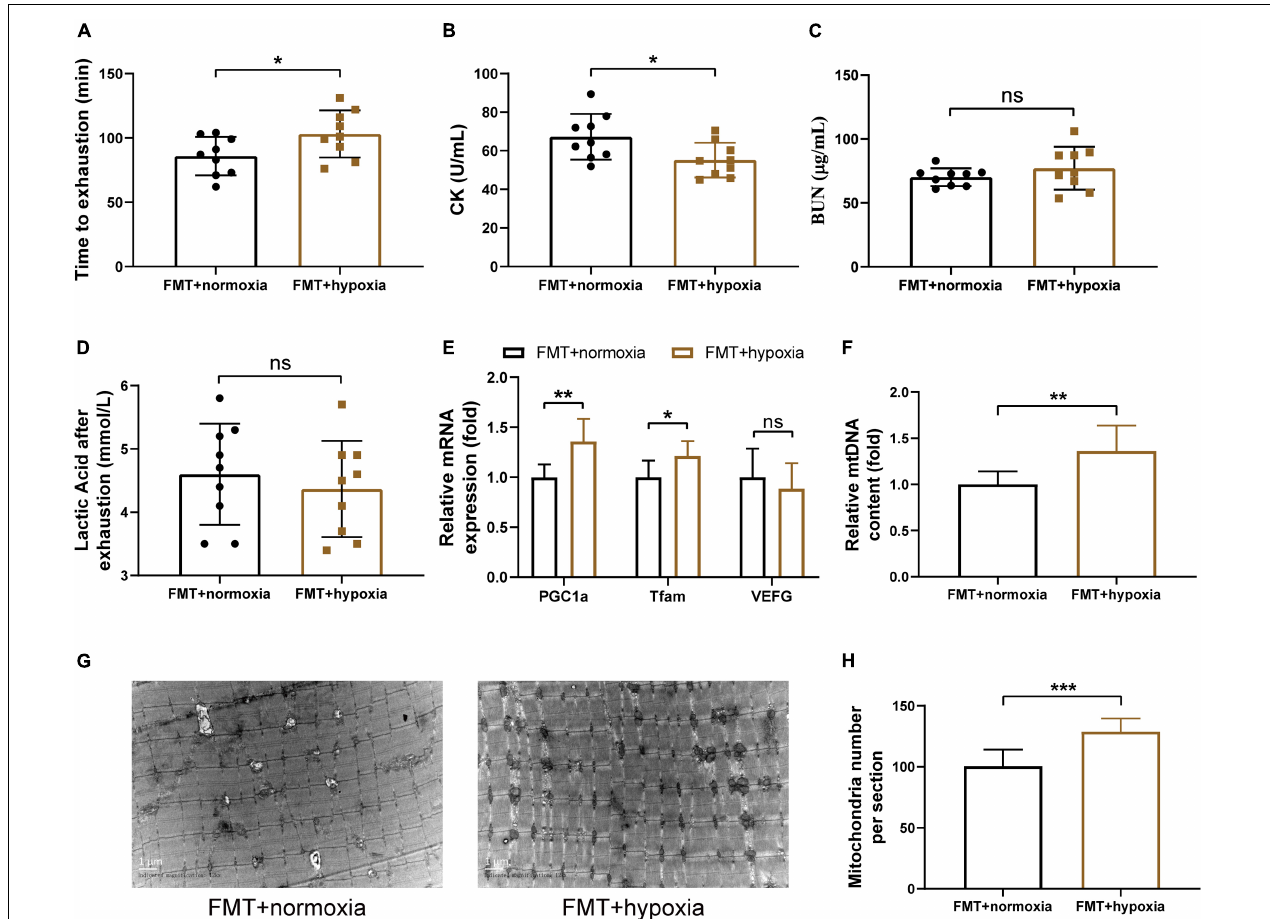
FIGURE 5 | SCFAs supplementation enhanced endurance capacity and promoted mitochondrial biogenesis. (A) Running time until exhaustion was recorded. CK (B) , BUN (C) , and lactic acid (D) were measured immediately after exhaustion. The expression of mitochondrial biogenesis (E) and the mtDNA content (F) were measured by RT-PCR. (G) Representative TEM images of gastrocnemius at a magnification of 12,000 × . (H) Quantification of the number of mitochondria per section. Data are presented as means ± SD. * p < 0.05, ** p < 0.01, *** p < 0.001 (Student’s t -test, ns, no